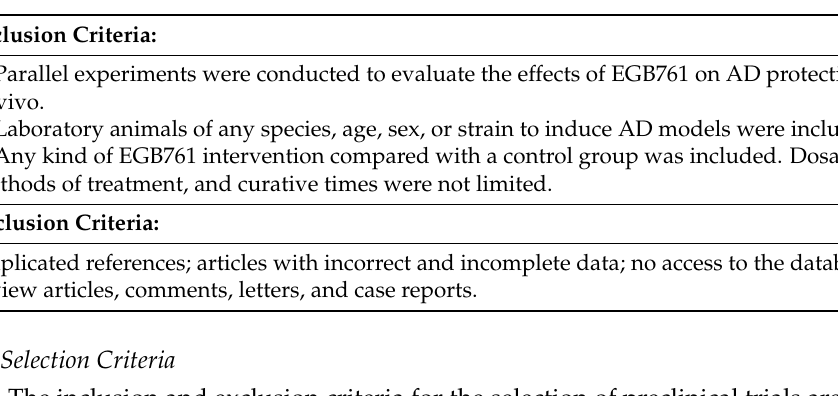
Table 1. Inclusion and exclusion criteria for selecting preclinical